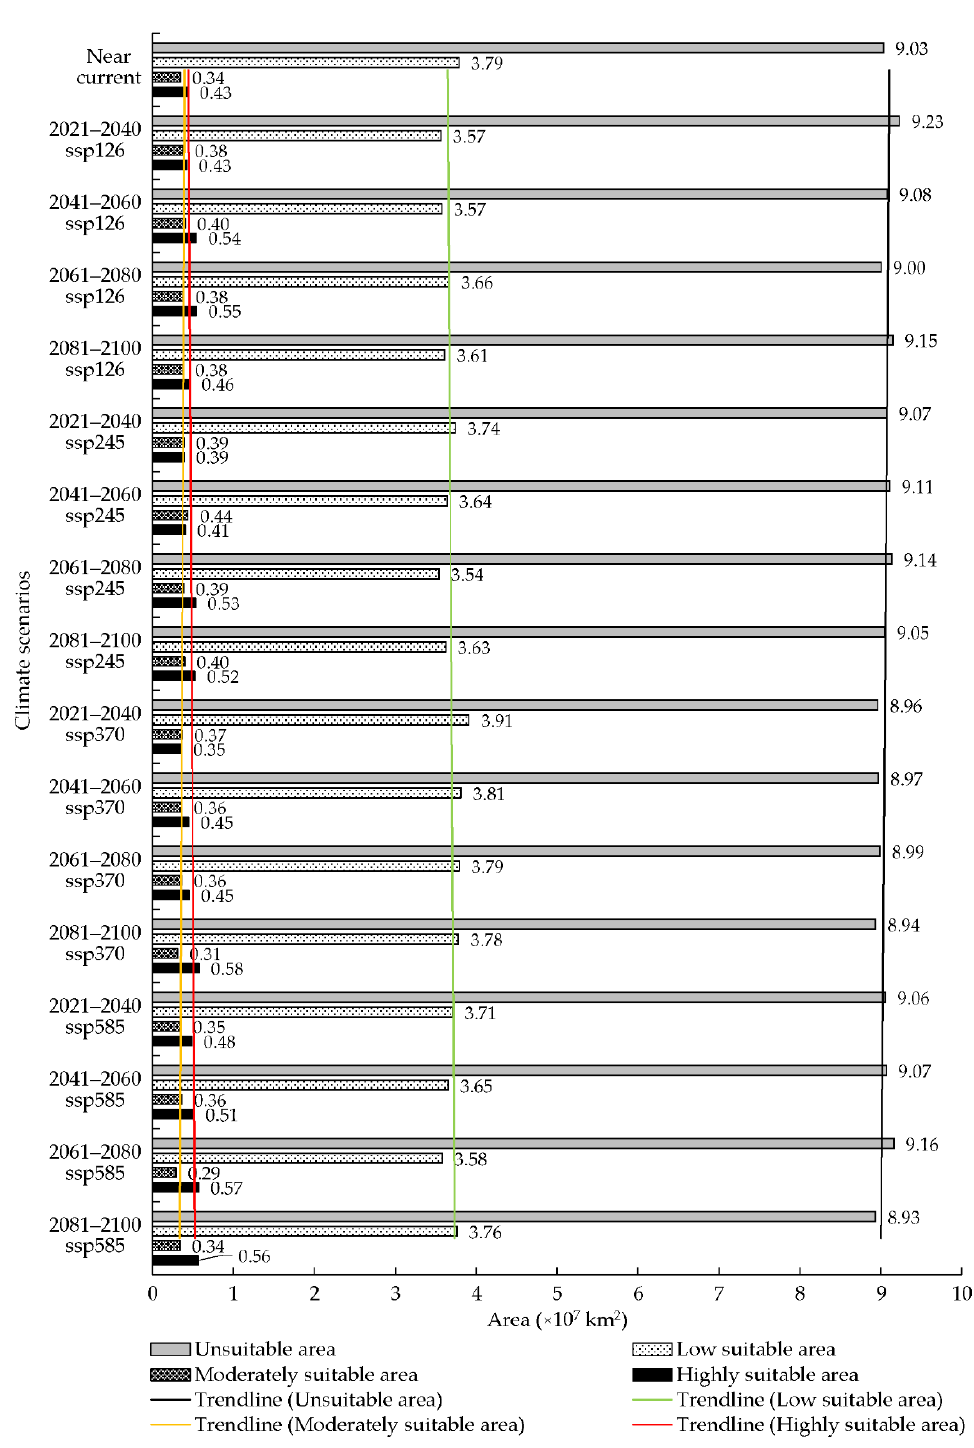
Figure 4. The worldwide suitable areas of S. juvencus under the near current and future climate